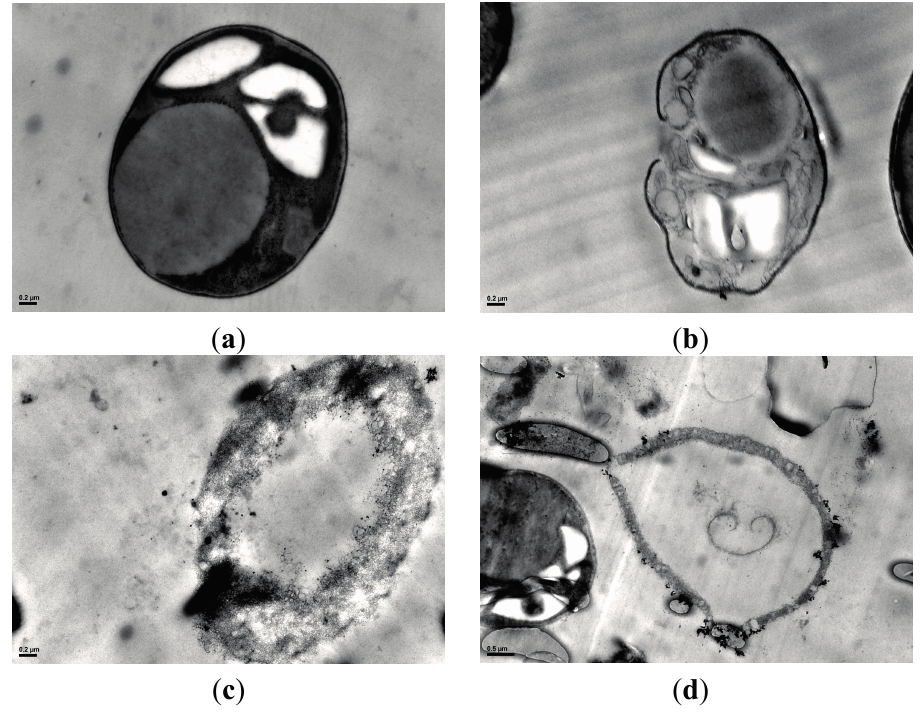
Figure 6. Transmission electron microscopy (TEM) images of algae cell before and after disruption. ( a ) TEM image of an intact cell of Neochloris oleoabundans (40,000×); ( b ) TEM image of an algal cell disrupted with ultrasonic wave (40,000×); ( c ) TEM image of an algal cell disrupted with high pressure homogenization (40,000×); and ( d ) TEM image of an algal cell disrupted with enzymatic hydrolysis